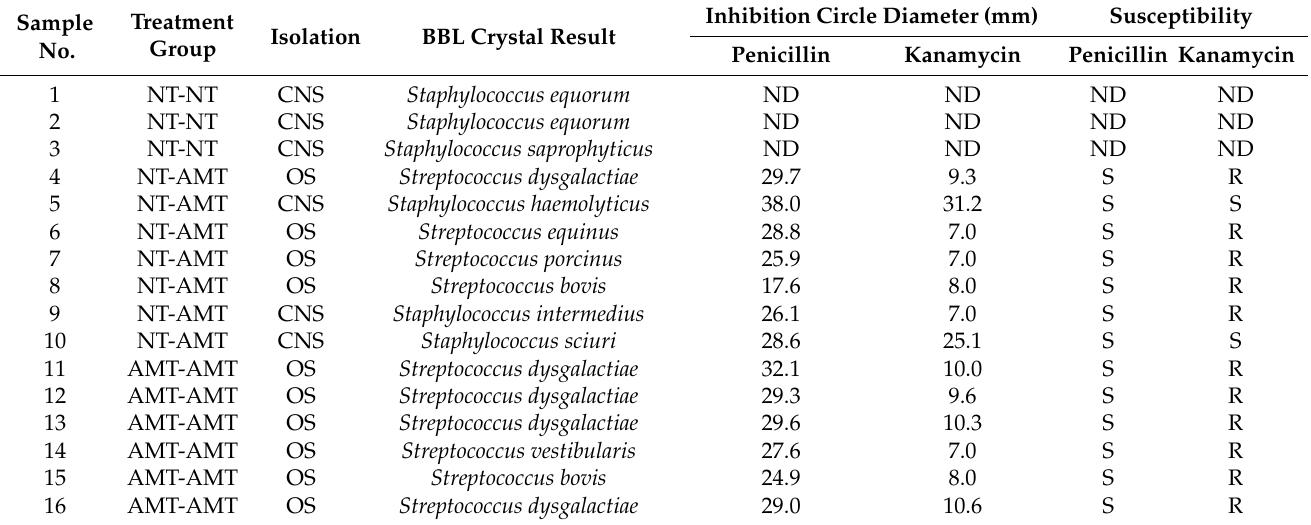
Table 3. Bacterial isolation and antimicrobial susceptibilities of antimicrobials of each sample based on the agar disk diffusion further simplified (simplified ADD)